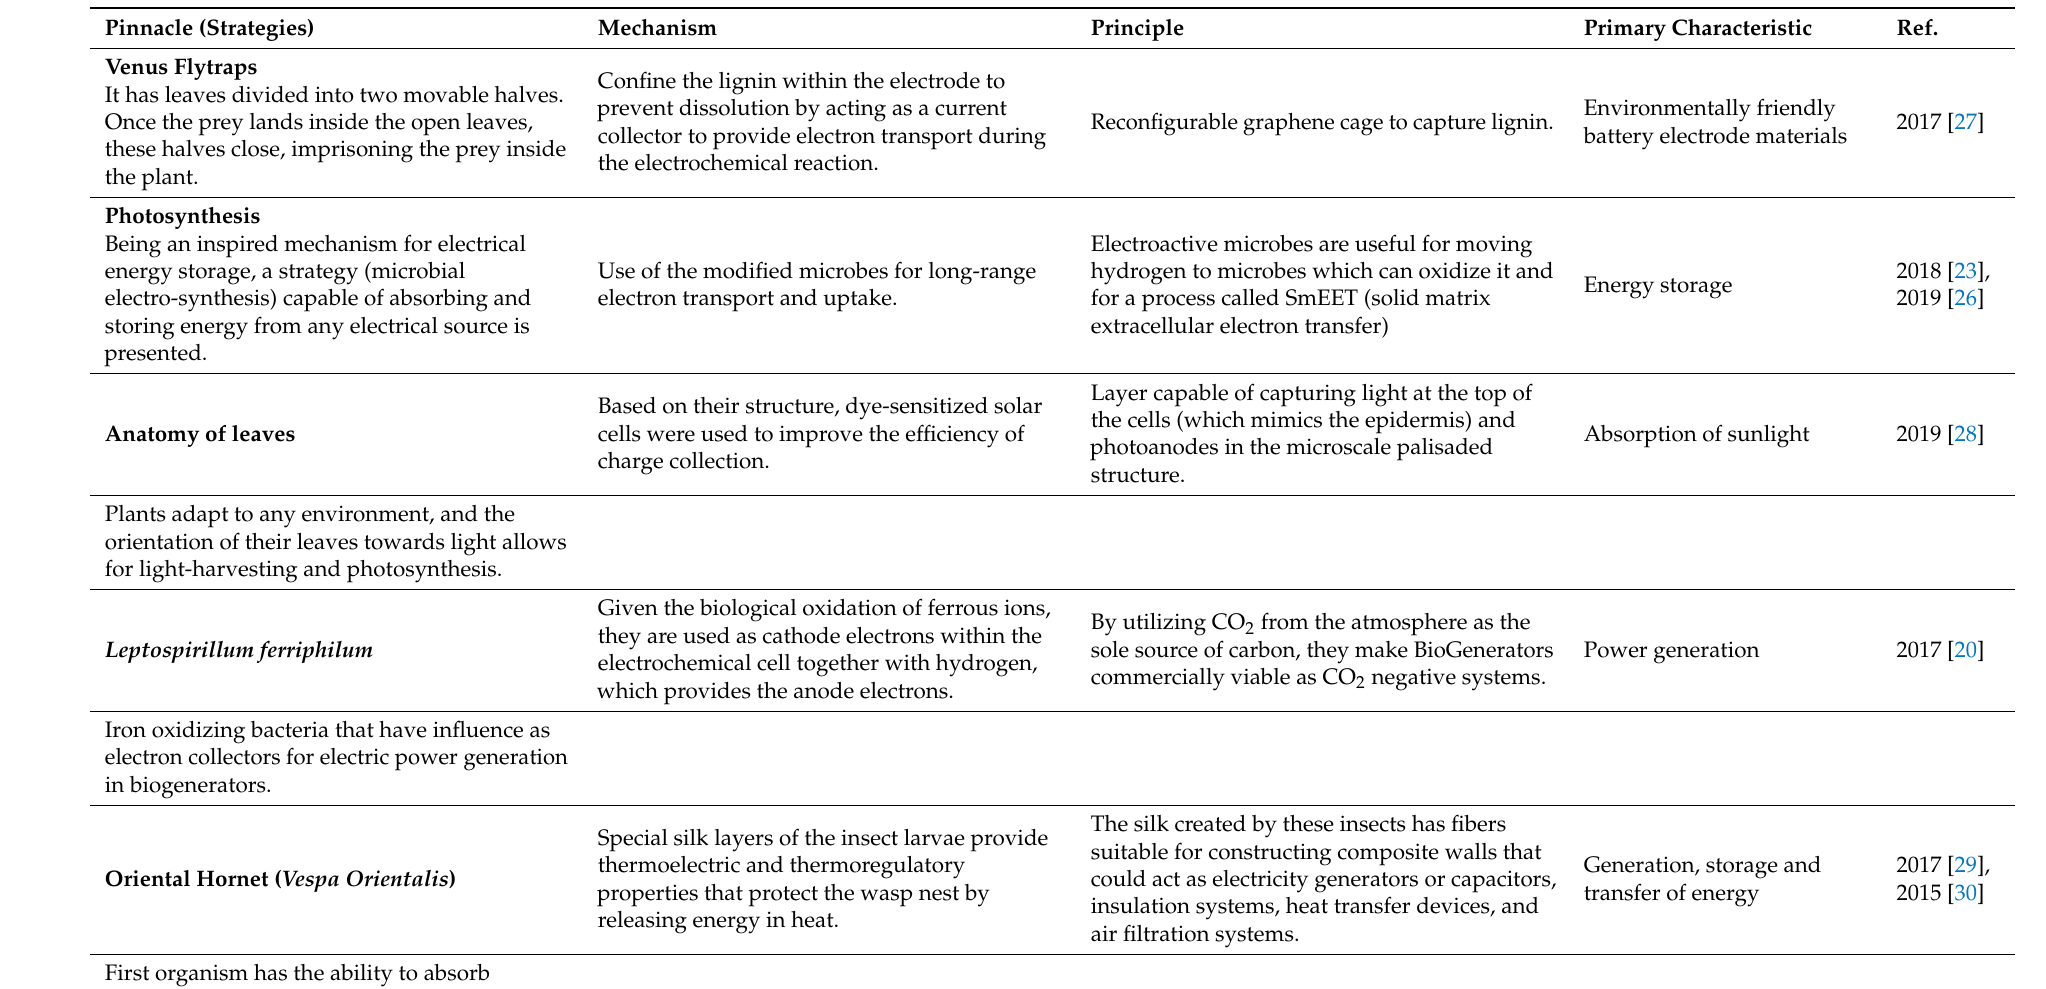
Table 3. Mechanisms inspired by nature for both storage and generation of electrical